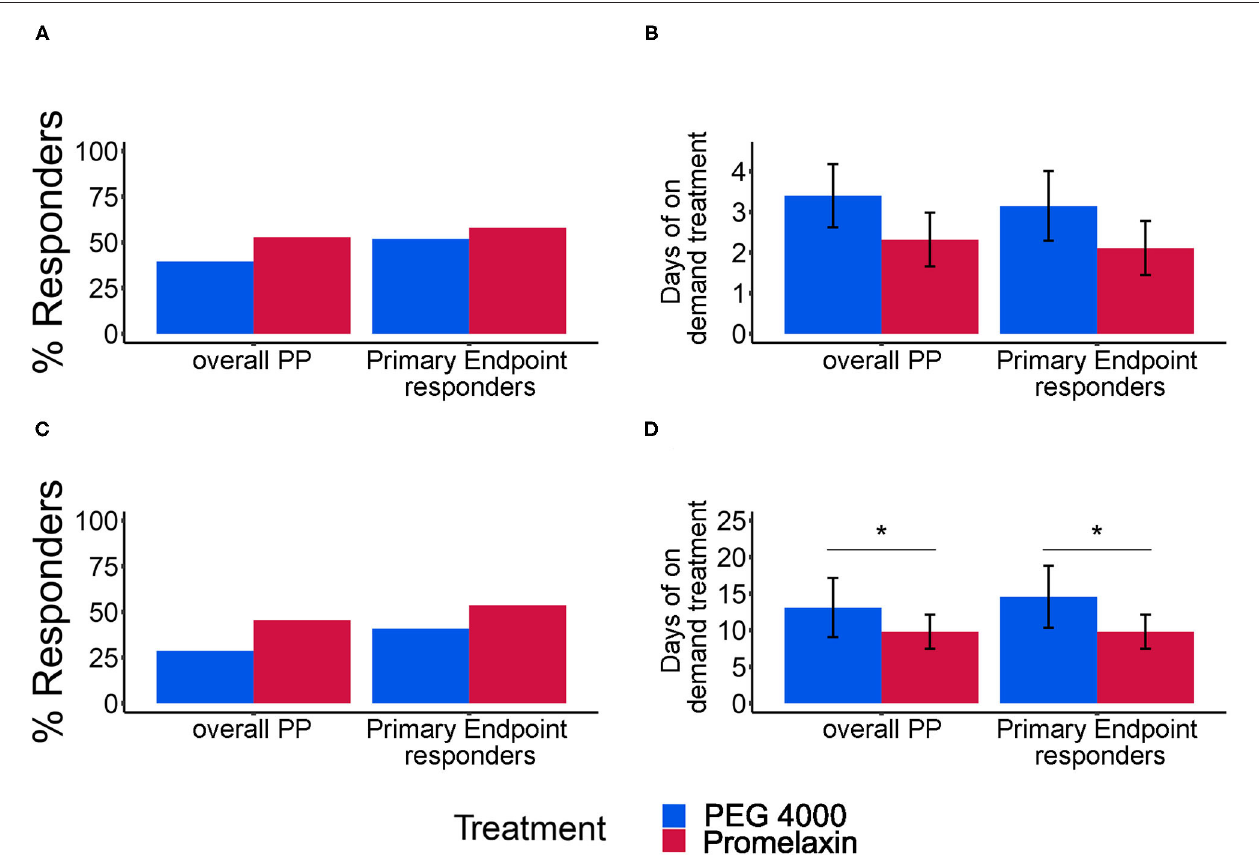
FIGURE 4 | Response rate for combined stool frequency and consistency and average days of treatment. (A,C) show the response rate (%) for the combined stool frequency and consistency secondary endpoints at V4 and V5, respectively. (B,D) show the average days of treatment (mean ± SE) at V4 and V5, respectively. In each panel, results of separate analyses either according to the PP population or to the subgroup of PP patients evaluated as responders to the primary endpoint (Primary Endpoint Responders) are depicted. Error bars represent Standard Error. (A) Overall PP: PEG, n = 38; Promelaxin, n = 36; Primary Endpoint responders: PEG, n = 25; Promelaxin, n = 31. (B) Overall PP: PEG, n = 15; Promelaxin, n = 19; Primary Endpoint responders: PEG, n = 13; Promelaxin, n = 18. (C) Overall PP: PEG, n = 35; Promelaxin, n = 33; Primary Endpoint responders: PEG, n = 22; Promelaxin, n = 28. (D) Overall PP: PEG, n = 10; Promelaxin, n = 15;